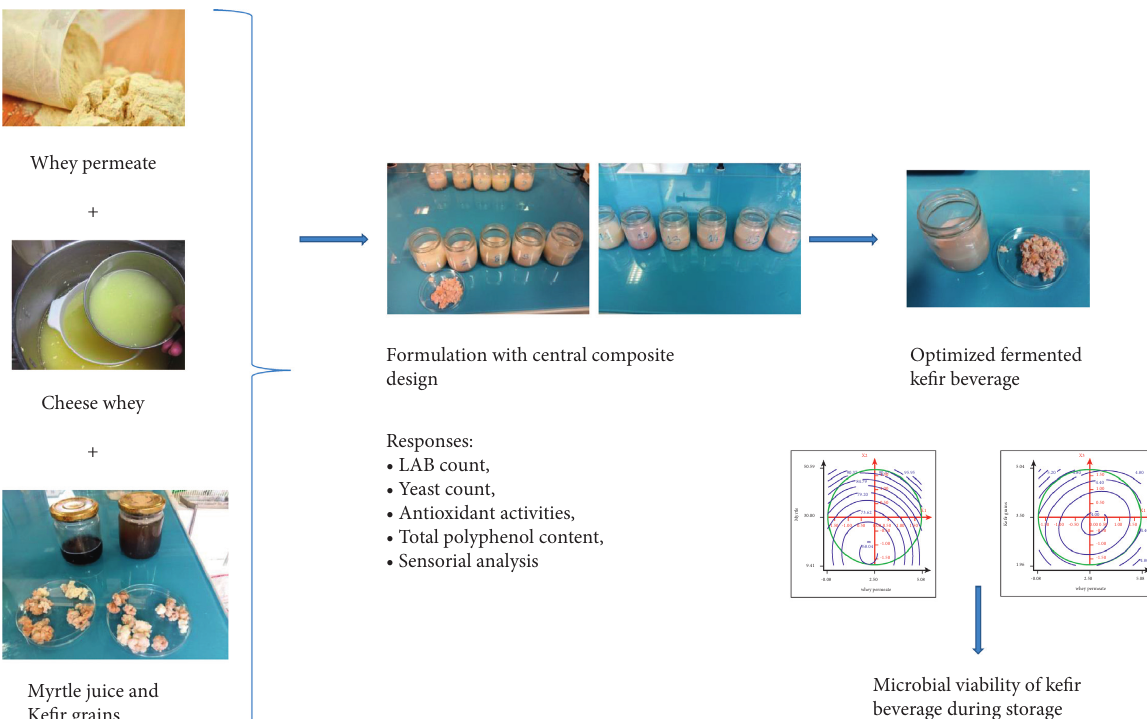
Figure 1: Whey valorization by developing a kefir-like functional beverage from cheese whey, whey permeate, and myrtle